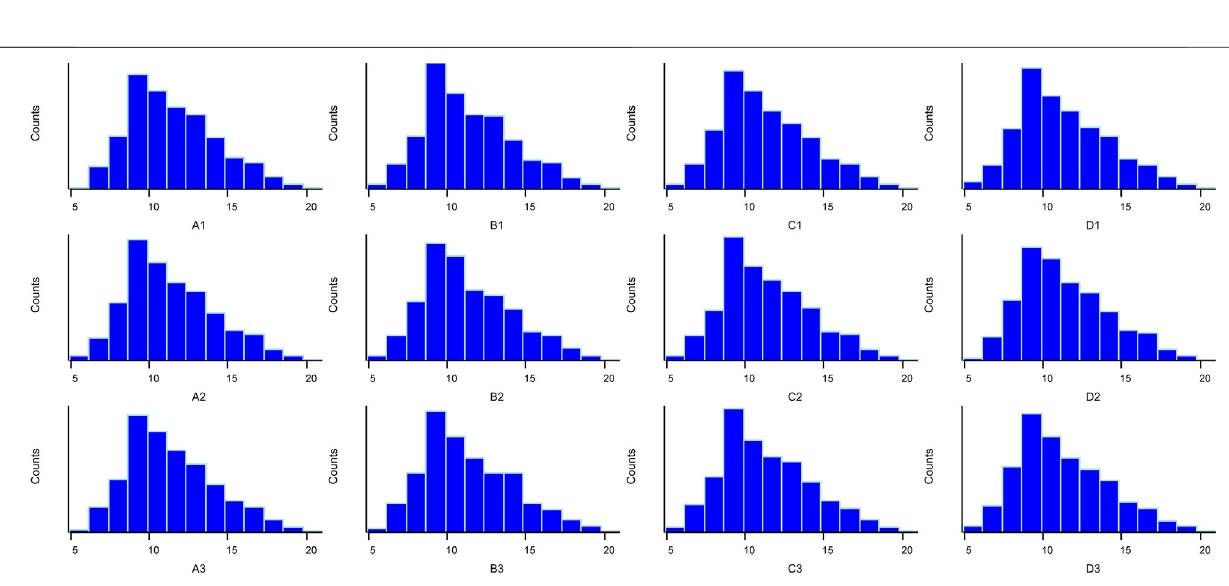
Frontiers in Molecular Biosciences |